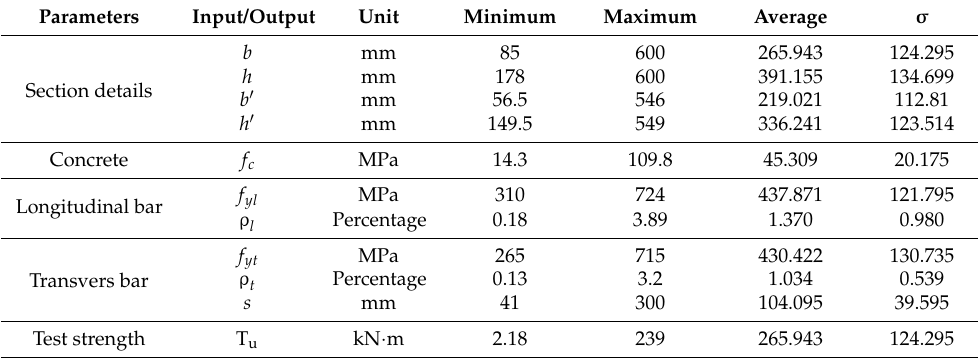
Table 1. The range of input and output parameters ( σ : Standard